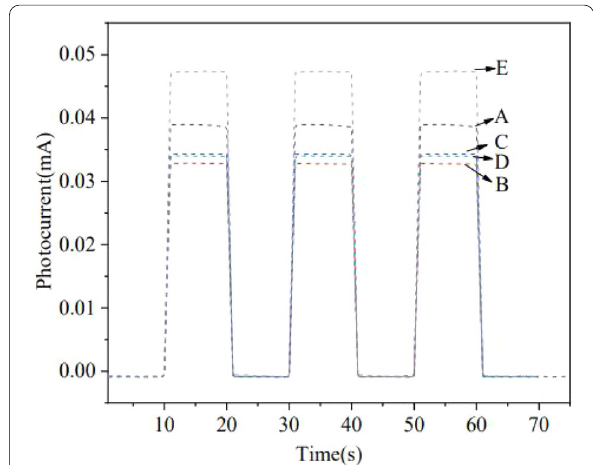
Fig. 7 Effects of EPS components on the efficiency of sulfate reduction of C09. a Rude EPS and CdS NPs; b without EPS, but with CdS NPs; c EPS with proteinasetreatment; d EPS with polysaccharidase treatment; e EPS with both proteinase andpolyaccharidase; f EPS with CdS NPs